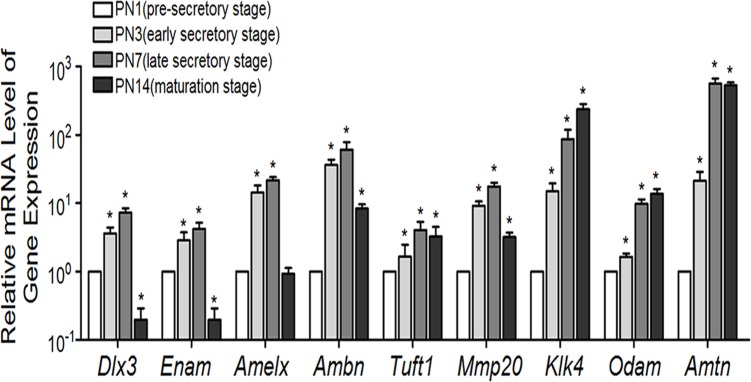
Expression patterns of Dlx3 and EMP genes at the mRNA level during amelogenesis.Real-time RT-PCR was used to analyze the expression levels of Dlx3 and EMP genes using RNA extracted from tooth germs at the indicated stages. The expression level at PN1 was set at 1, and the fold-changes at other stages were calculated relative to PN1. The data represent three independent experiments, and are shown as mean ± SD. *P <0.05 vs. the control (PN1 group). Enam, Enamelin; Amelx, Amelogenin; Ambn, ameloblastin; Tuft, Tuftelin-1; Mmp20, Matrix metalloproteinase 20; Klk4, kallikrein 4; Odam, Odontogenic ameloblast-associated protein; Amtn, Amelotin.